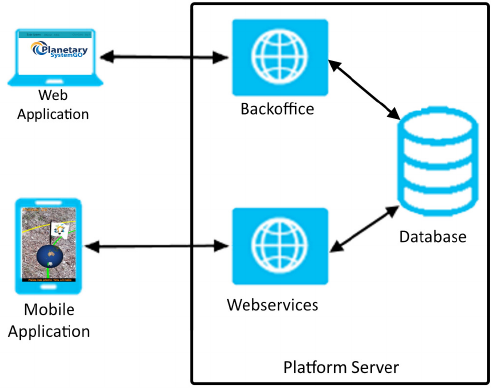
Figure 3. The back-end architecture of PlanetarySystemGO.